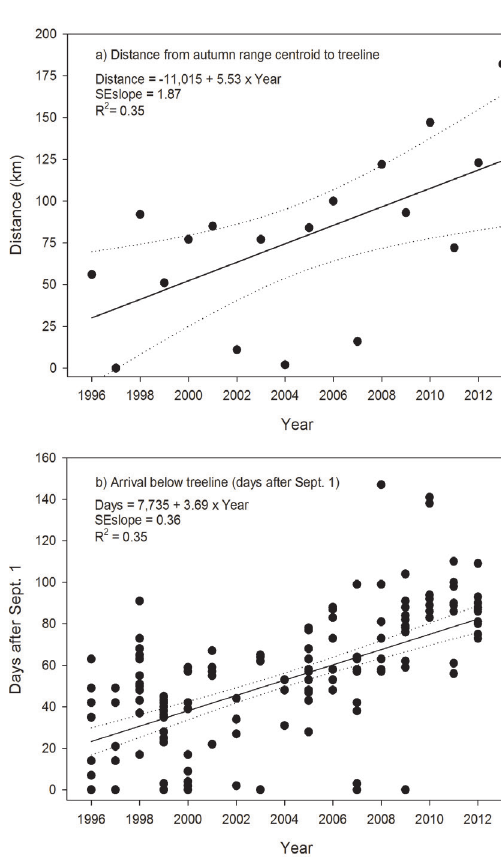
Note: circles denote values for each individual that spent at least part of each winter below the treeline. Figure 4. Trend (red line) and 95% confidence in- terval (blue lines) in (a) distance (km) from the an- nual autumn range centroid to the treeline for the Bathurst caribou herd and (b) number of days after 1 September of each year that individual females from the Bathurst caribou herd arrived below the